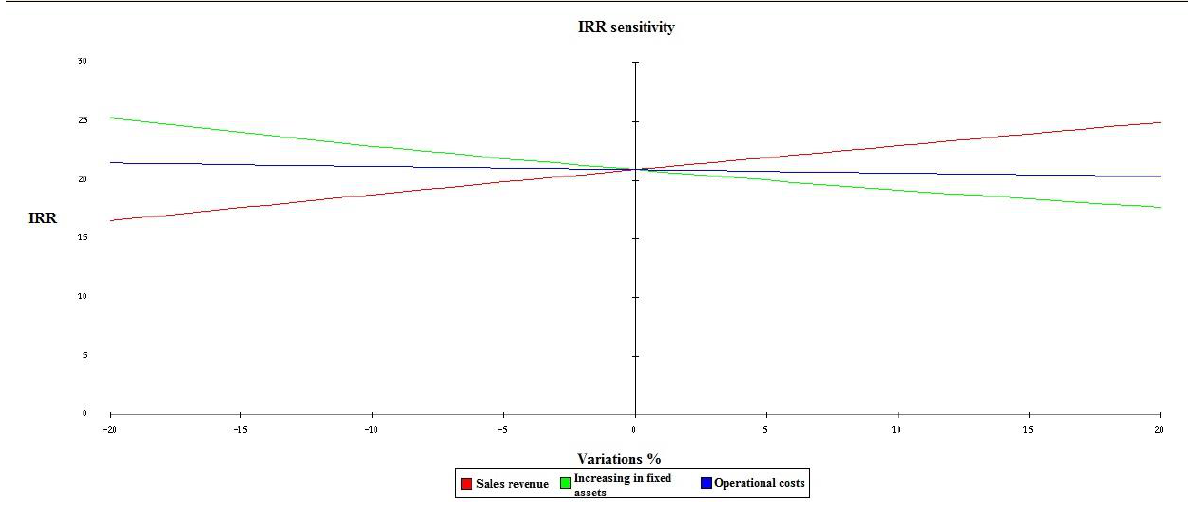
Figure 4. Sensitivity Analysis due to IRR Sensitivity (per one-tenth